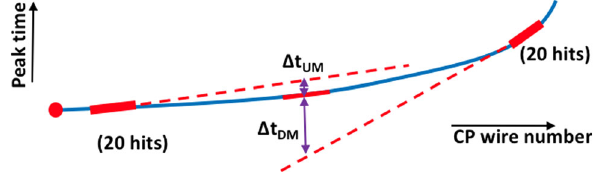
Fig. 6 Diagram of the MCS test for a candidate muon track